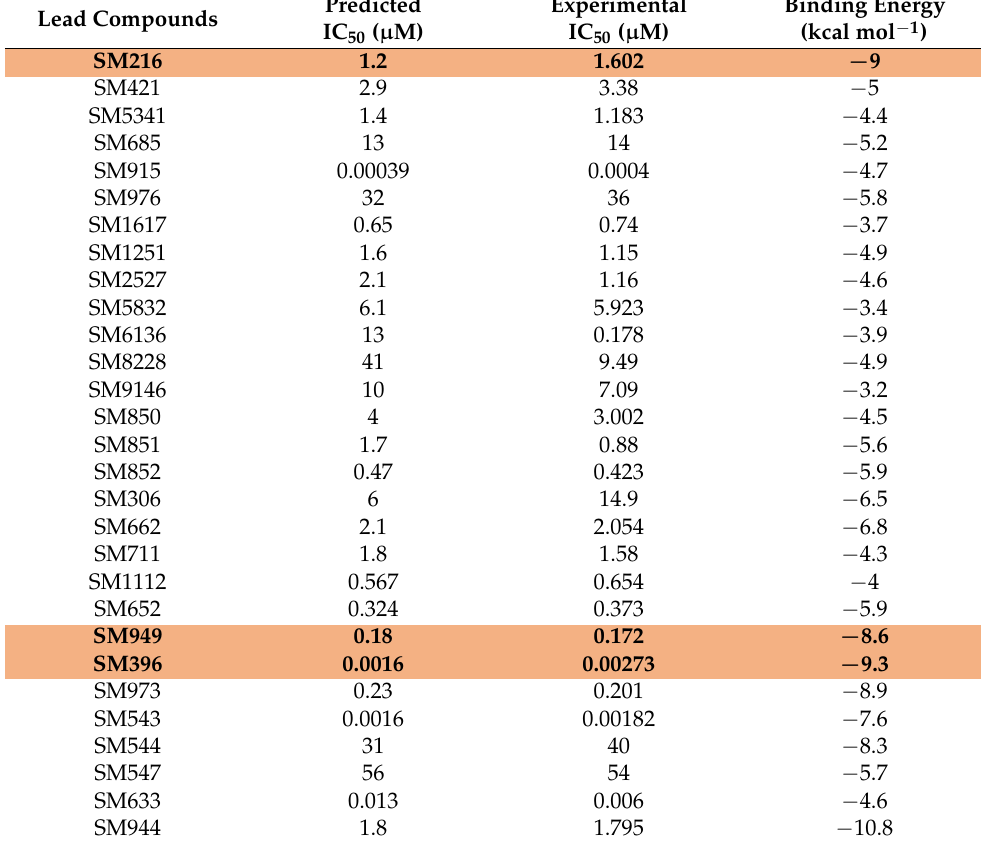
Table 1. Experimental, predicted activity, and binding energy of the compounds. The data for top three compounds was shown in bold and highlighted in light red color. Predicted Lead Compounds IC 50 ( µ